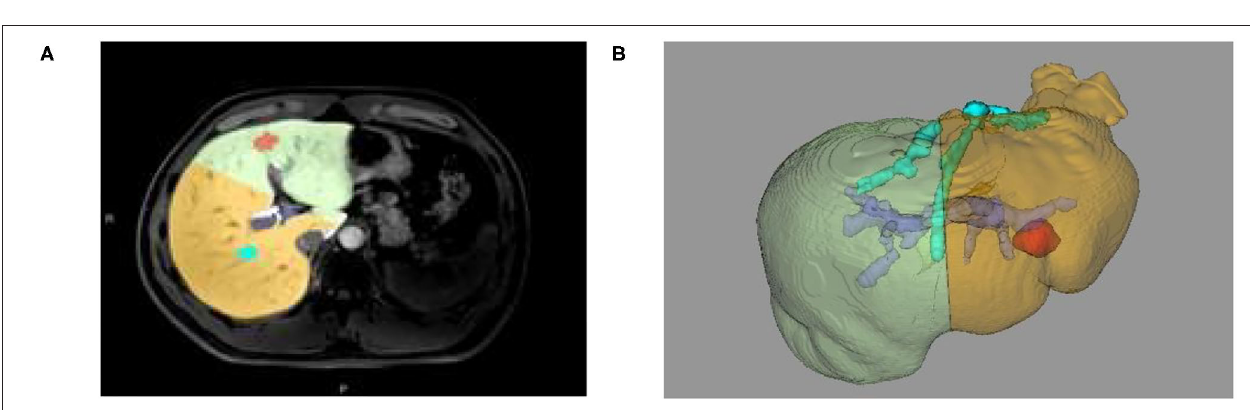
FIGURE 4 | (A) Two-dimensional MRI enhanced image, (B) 3D reconstruction based on liver segmentation and tumor growth model on MRI